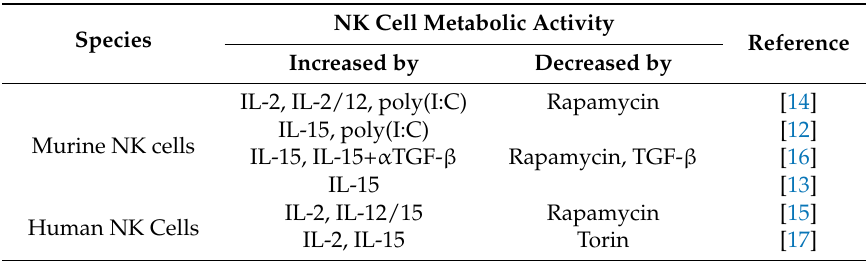
Table 1. Studies analyzing natural killer (NK) cell metabolic activity using Seahorse technology.